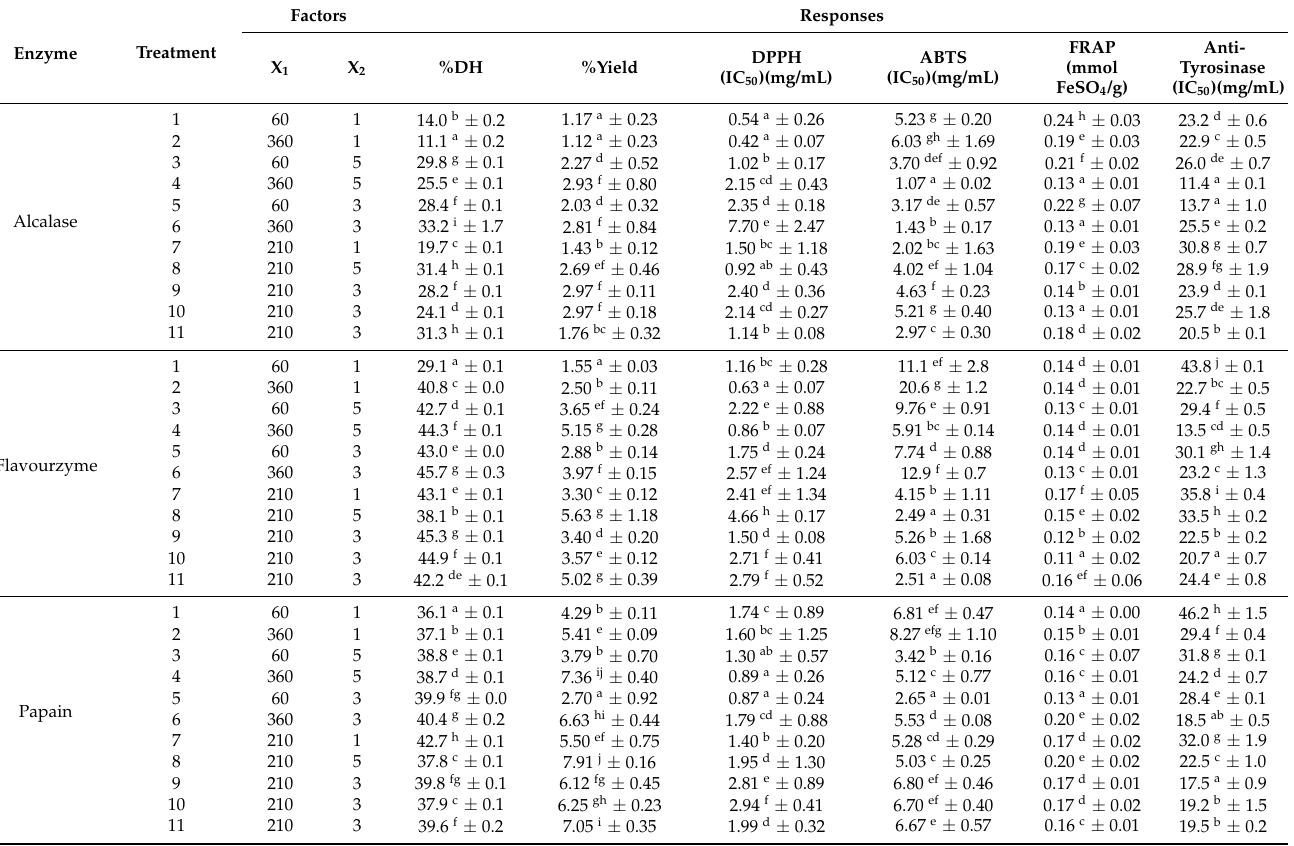
Table 1. Experimental units and response variables for DH, yield, DPPH and ABTS radical scavenging activity, FRAP value, and tyrosinase inhibitory activity of jellyfish protein hydrolyzed using alcalase, flavourzyme, and